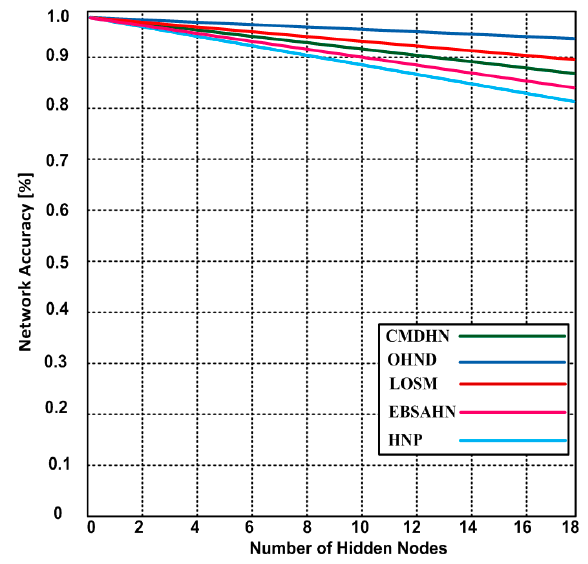
Figure 7. The network accuracy in presence of hidden nodes of OHND and other competing